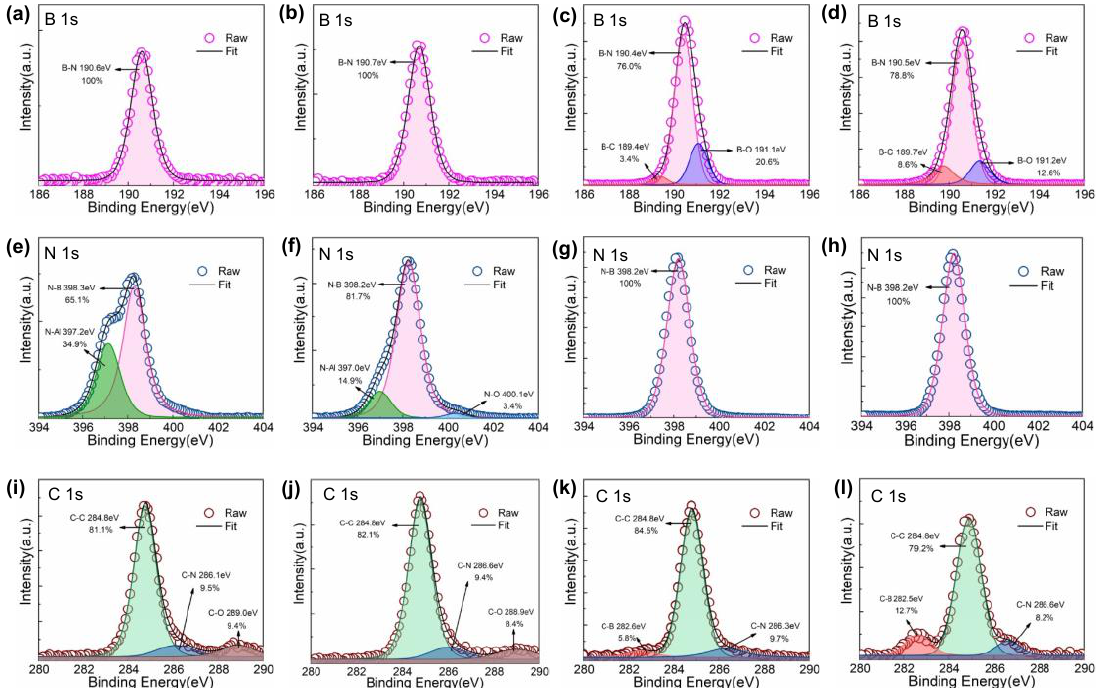
Figure 4. The XPS spectra of ( a – d ) B-1s, ( e – h ) N-1s and ( i – l ) C-1s in h-BN film under four FME modes. ( a , e , i ) NH 3 /TEB, ( b , f , j ) NH 3 /Itrp/TEB, ( c , g , k ) NH 3 /TEB/Itrp, ( d , h , l ) NH 3 /Itrp/TEB/Itrp.